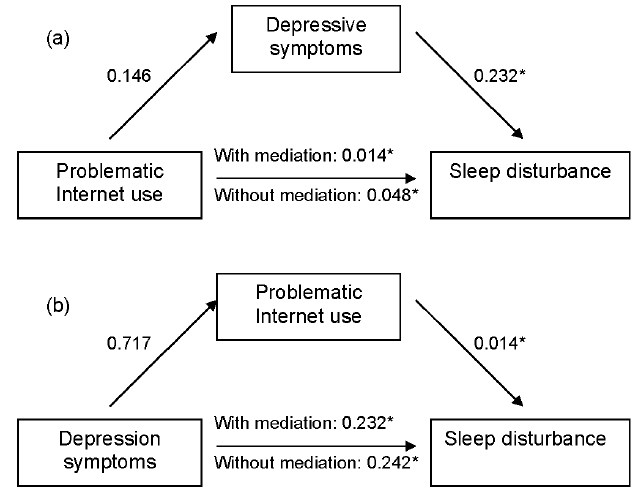
Figure 1. Mediation analyses of relationship between problematic Internet use, depressive symptoms, and sleep disturbance. ( a ) Depressive symptoms as a mediator variable between problematic Internet use and sleep disturbance; ( b ) Problematic Internet use as a mediator variable between depressive symptoms and sleep disturbance; * p < 0.001.